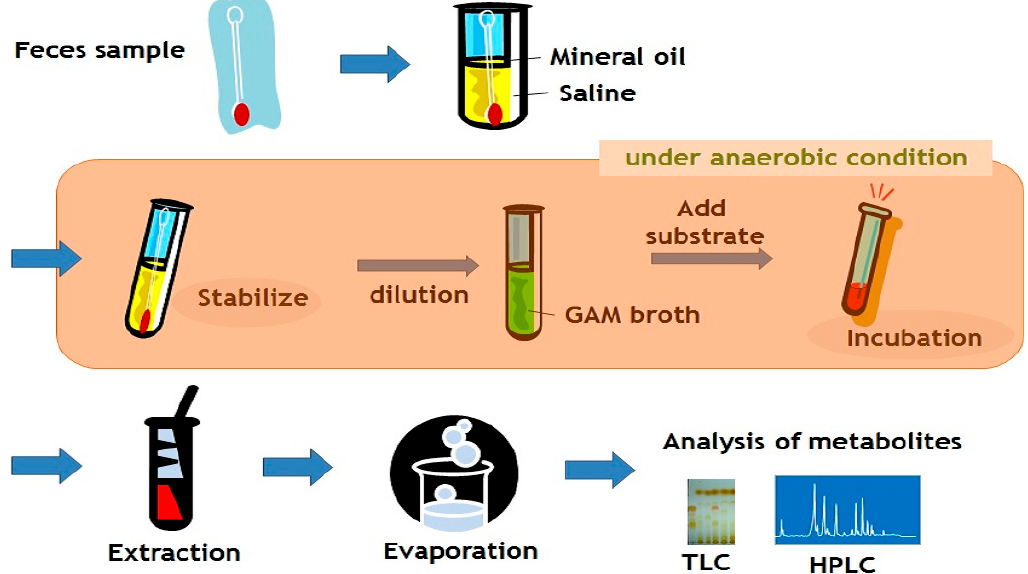
Figure 2. Experimental procedure for the screening of gut bacterium.